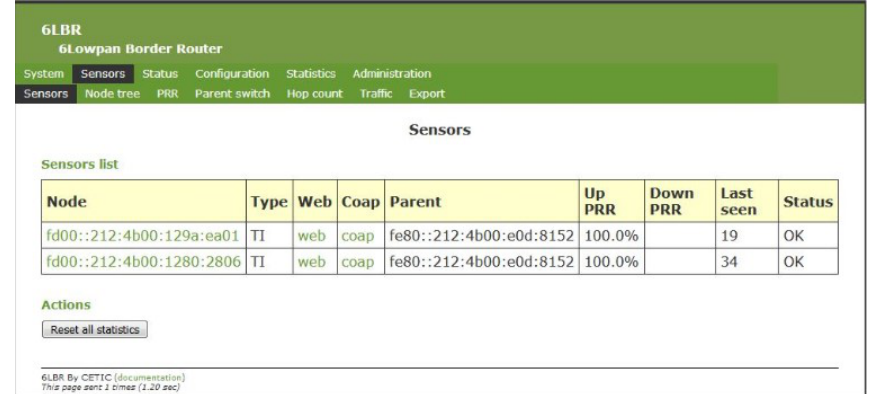
Figure A6. BeagleBone Black: Sensors